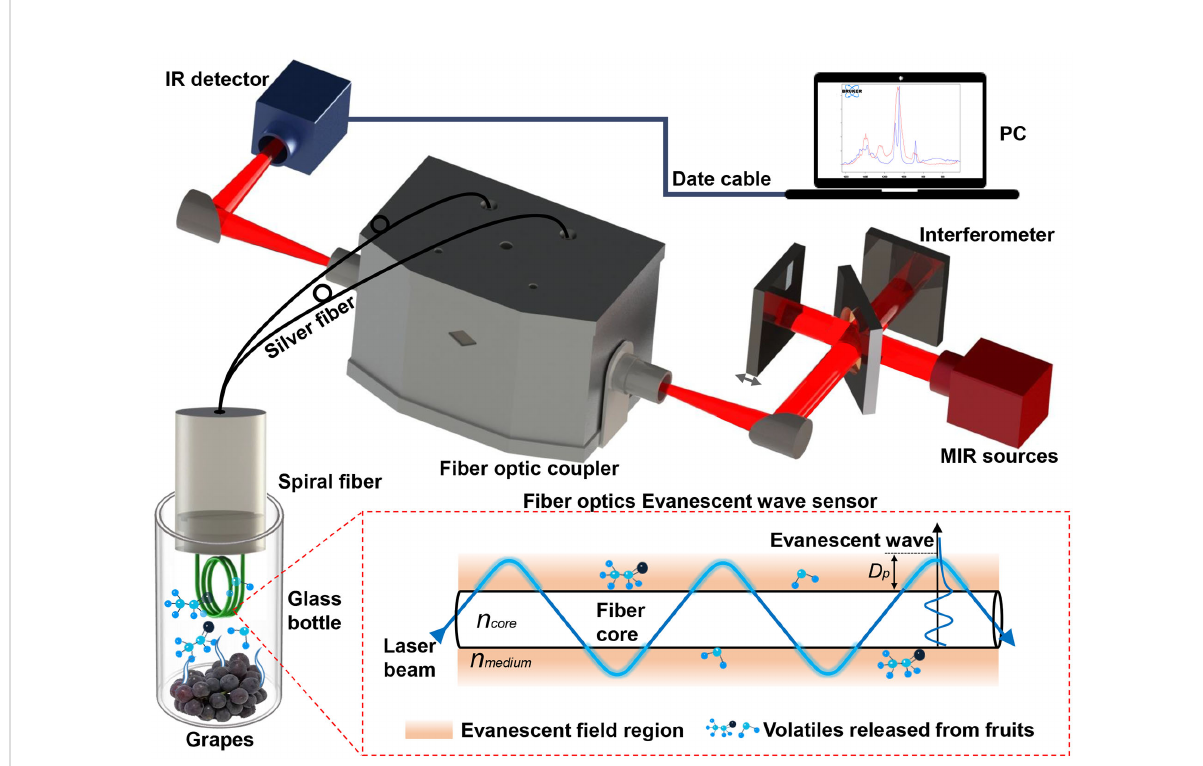
FIGURE 1 Schematic diagram for detecting volatile compounds released from grapes in situ based on the MIR FOEW